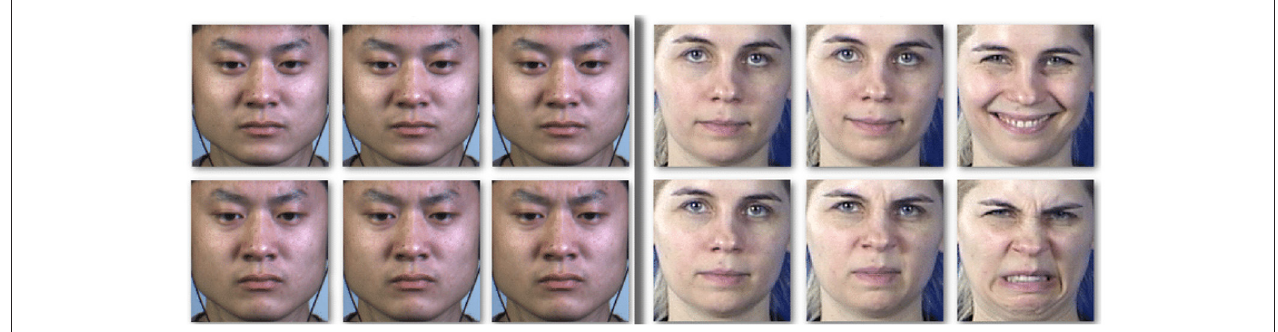
FIGURE 1 | Facial micro-expressions compared to facial macro-expressions. Facial micro-expressions (left) and macro expressions (right) for happiness (line1) and disgust (line2), from CASME II (Pantic et al., 2005) and MMI (Yan et al., 2014) datasets (Allaert et al.,